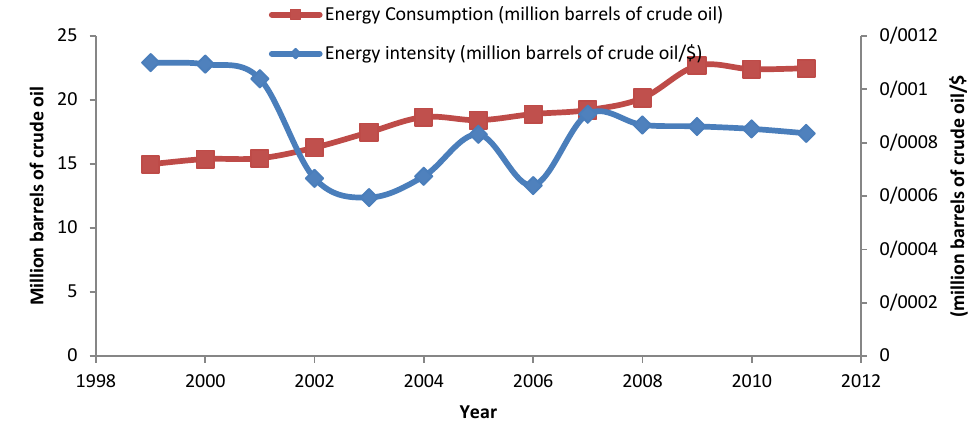
Figure 5. The values of energy consumption and energy intensity in the food and beverage industries of Iran over a period of 13 years.